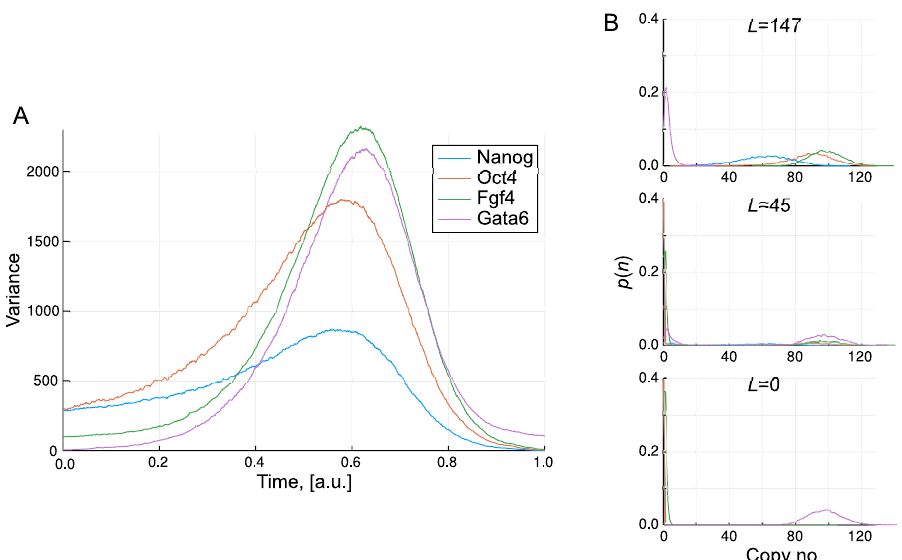
Fig 8. The transition state in a transitory landscape. (A) The variance of the transcription levels across 10,000 simulations in which L is linearly decreased with time as L = 150(1 − t ); (B) Probability distributions of the transcription levels at three different values of L . The high variance “transition state” corresponds to intermediate values of L at which transitions from the stem cell to differentiated state begin to occur.